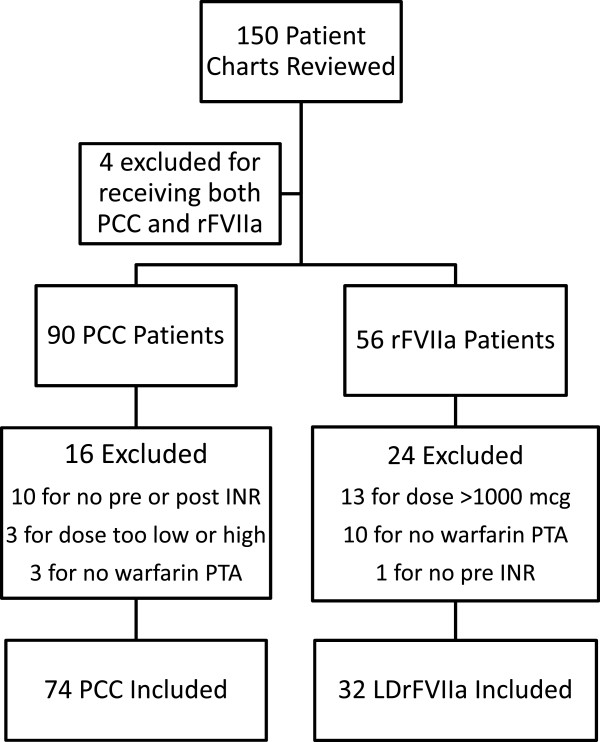
Subject selection. PCC3, 3 factor prothrombin complex concentrate; LDrFVIIa, low dose recombinant factor VII activated.